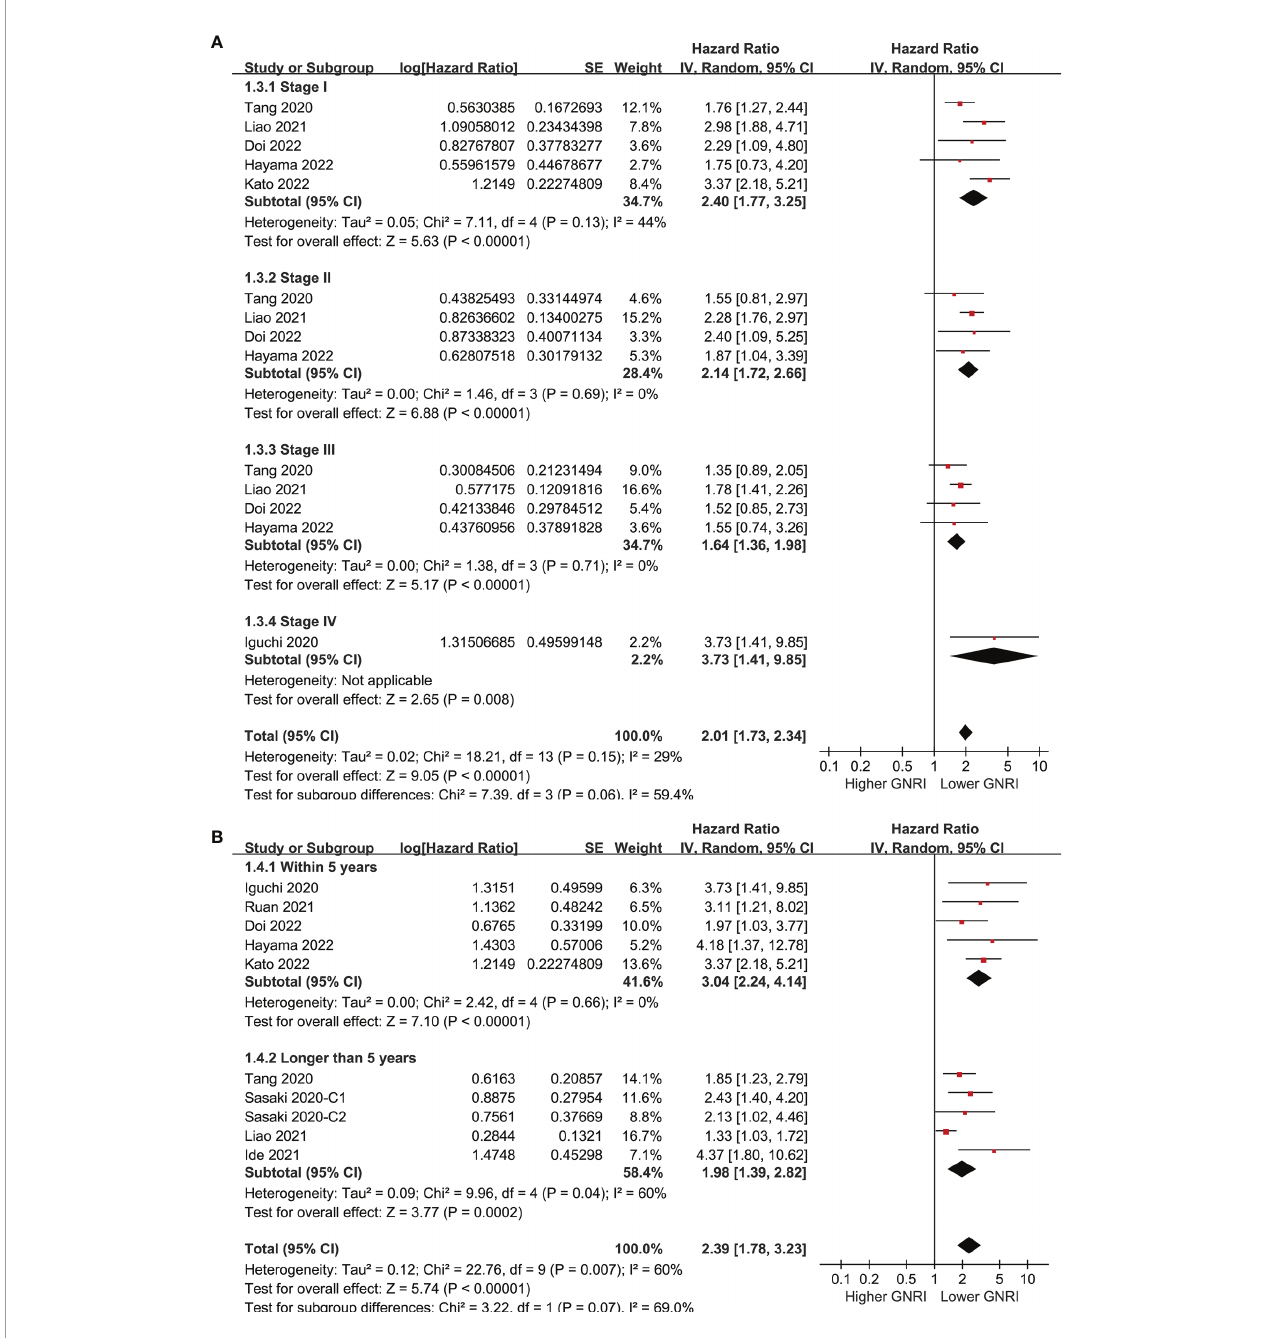
FIGURE 3 | Forest plots for the subgroup analysis regarding the association between GNRI and OS in patients with CRC; (A) subgroup analysis according to the stage of cancer; and (B) subgroup analysis according to the follow-up